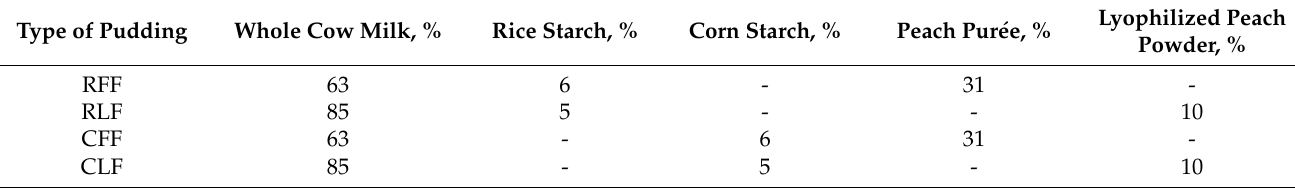
Table 1. Pudding formulations (RFF—rice starch, peach pur é e; RLF—rice starch, lyophilized fruit; CFF—corn starch, peach pur é e; CLF—corn starch, lyophilized fruit). Type of